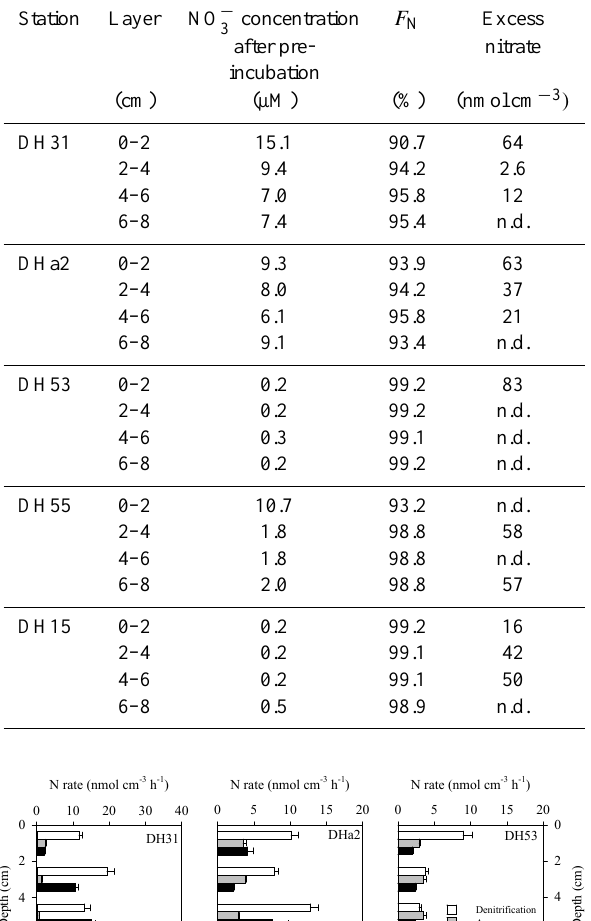
Table 3. Nitrate concentration after pre-incubation, 15 NO − fraction ( F N ) and excess nitrate stored by nitrate storing organisms in each layer. n.d.: not detectable.